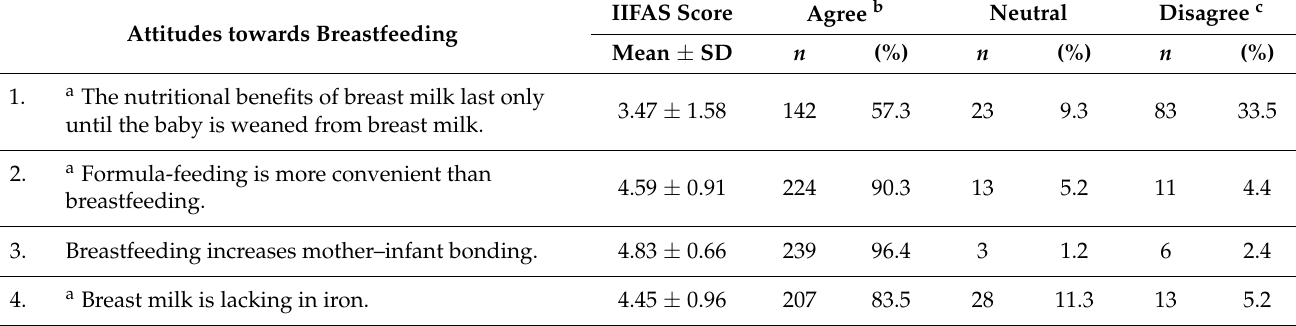
Table 2. Attitudes towards breastfeeding among mothers of premature infants in Neonatal Intensive Care Units ( n = 248). Attitudes towards